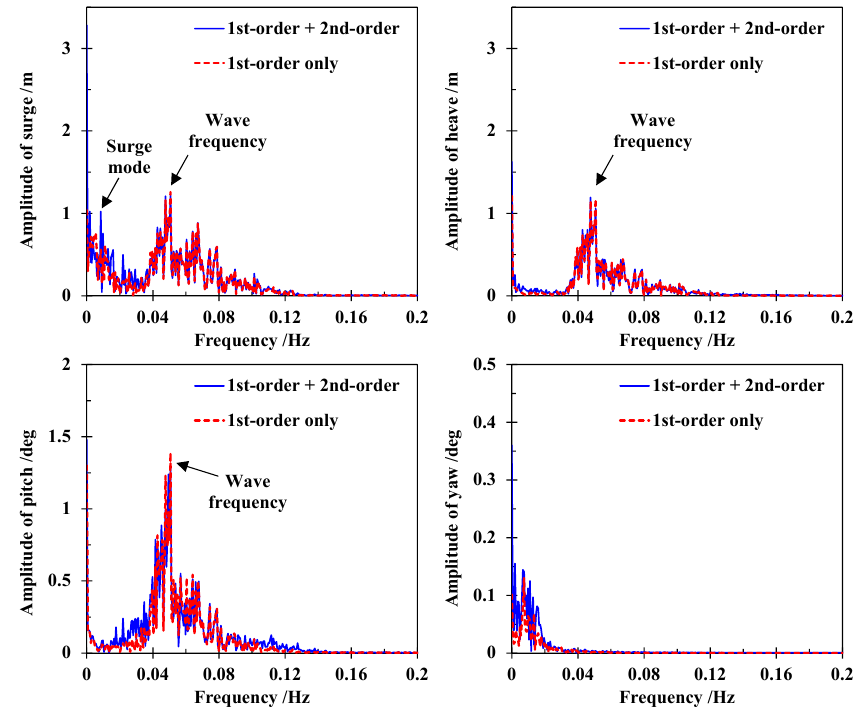
Figure 8. Spectral amplitudes of the platform motions under the extreme condition.